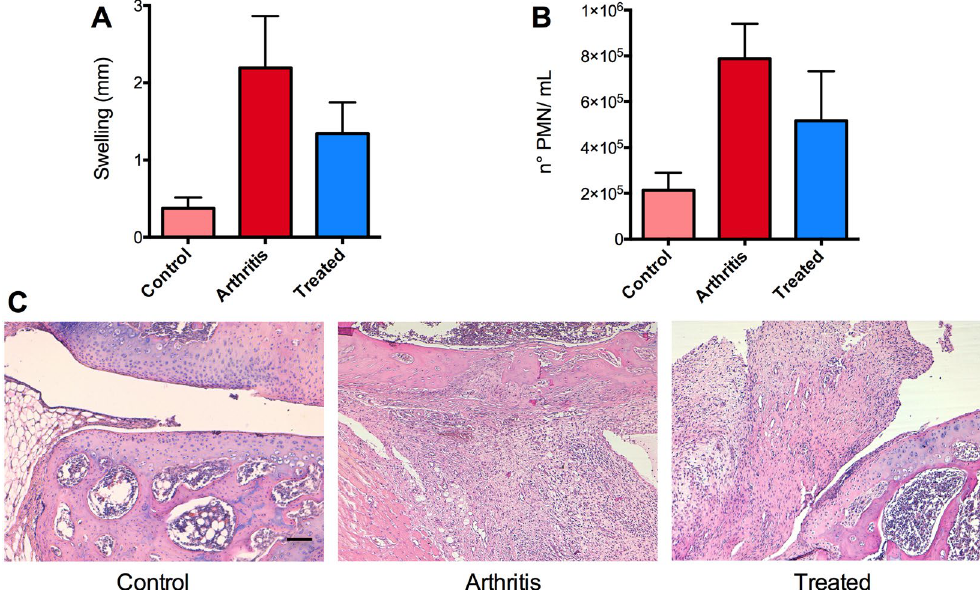
Figure 1. Effect of Humira on the development of antigen-induced arthritis in rats. Two groups of rats were injected intravenously with Humira (300 μ g - Treated) or saline (Arthritis) after intra-articular administration of mBSA to induce arthritis. Contralateral joints represent Control group. Animals were euthanized and examined for joint swelling ( A ) and polymorphonuclear neutrophil (PMN) counts in synovial lavage fluids ( B ). Values are the mean + / − SEM of 6 rats per group. Tissue damages ( C ) was also visualized by histological analysis. In the control image we can appreciate a healthy cartilage and synovial tissue, while arthritis samples show iperplastic synovial tissue associated with a huge infiltration of inflammatory cells and a severe cartilage degradation. Tissue of Humira-treated animals show a reduced thickness of the synovial membrane with a decreased infiltration of inflammatory cells and a preserved cartilage. The scale bar is the same for all images: 50 μ